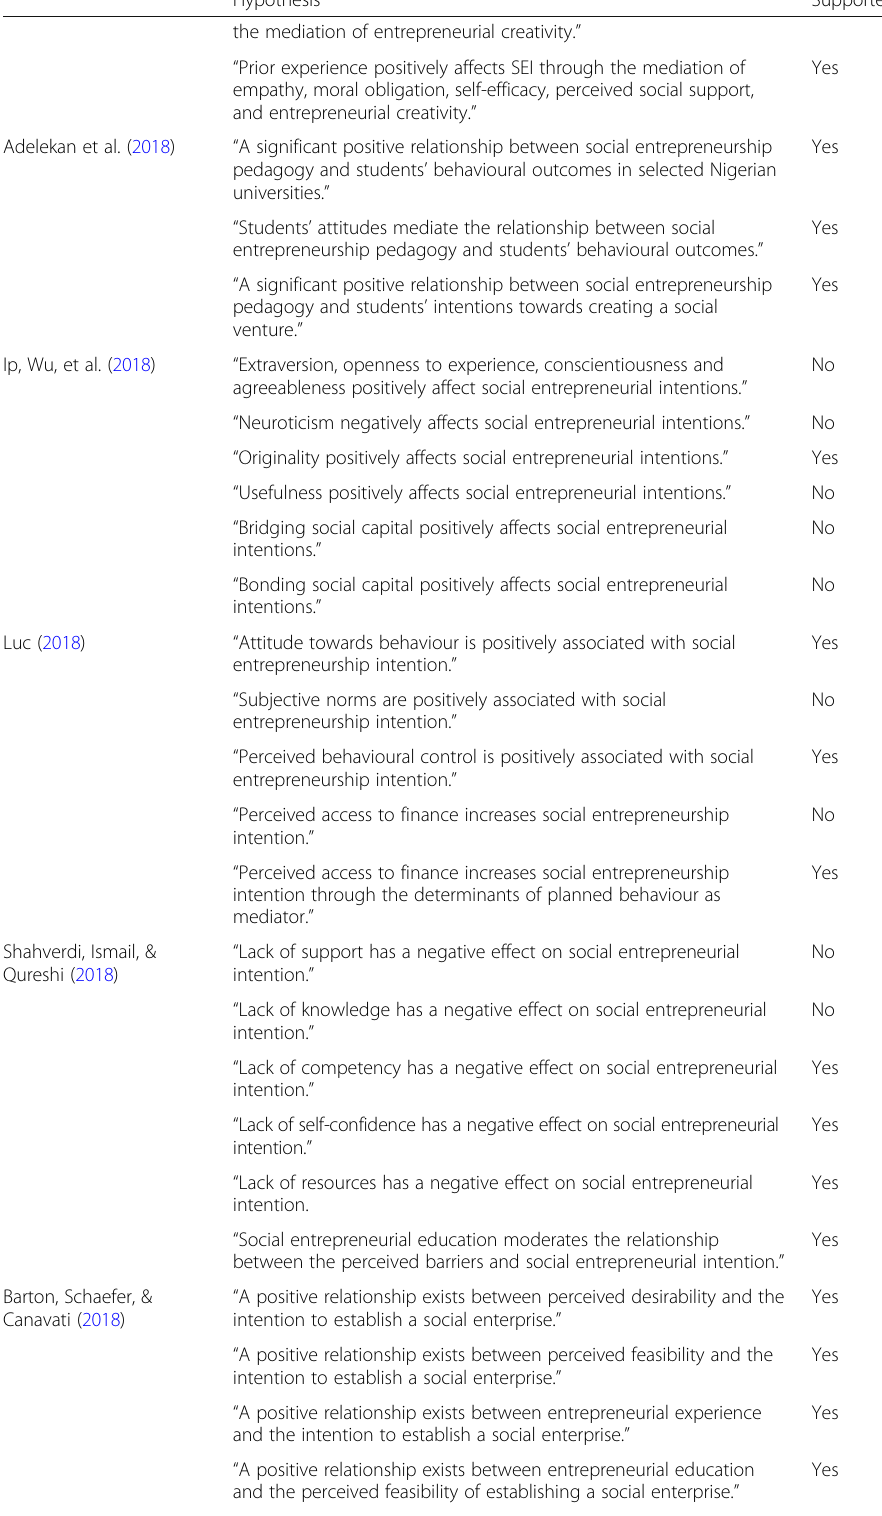
Table 2 Tabulated synthesis of results across different studies